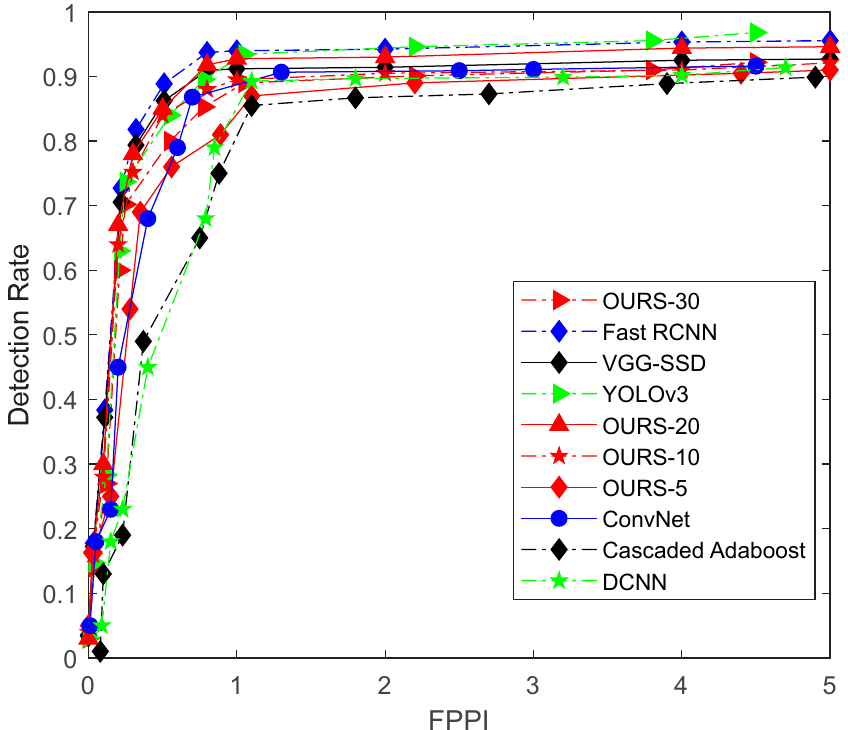
Figure 8. ROC curves for the performance of several offline learning algorithms using the KITTI test data set.